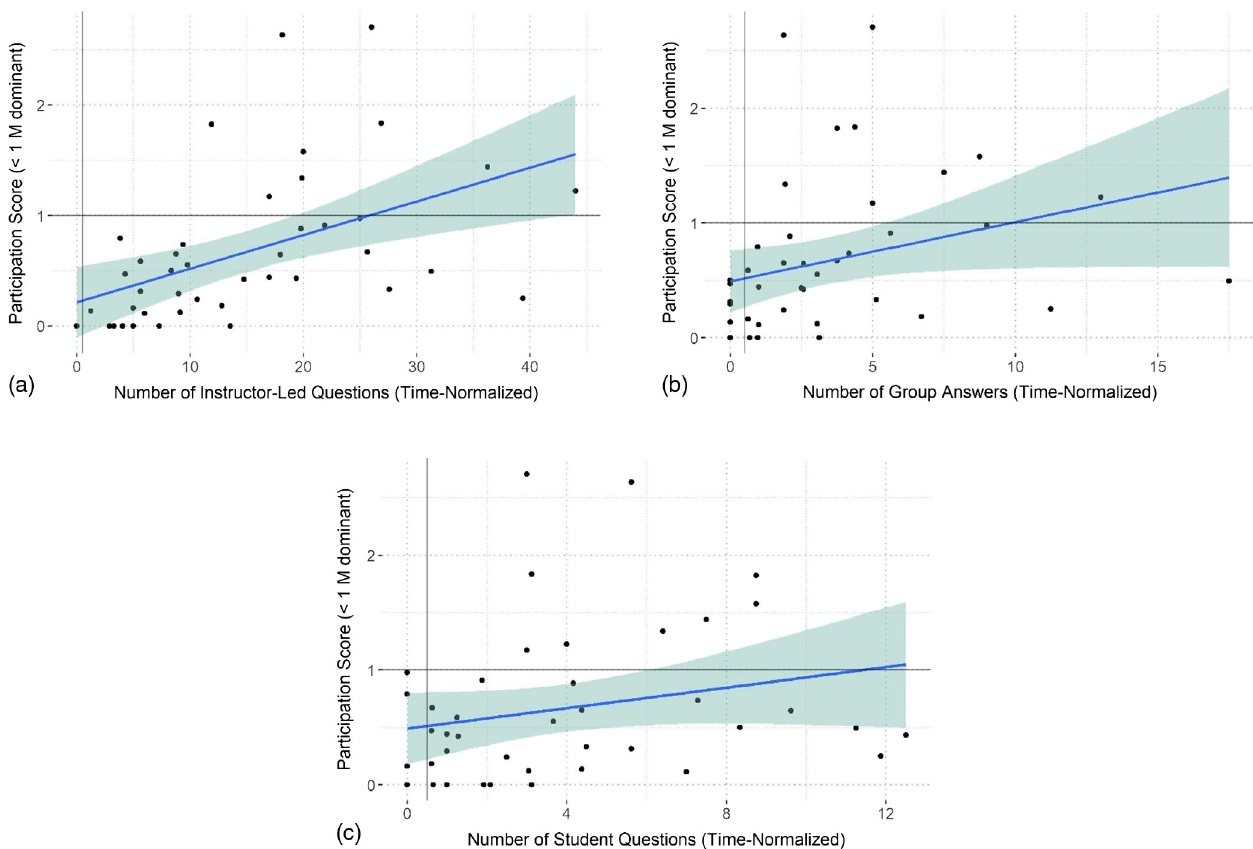
FIG. 5. An increase in the number of (a) instructor-prompted questions, (b) group responses, and (c) student questions appears to be strongly correlated with a higher participation score (regardless of category). Scatterplots of physics observations by the (time- normalized) number of instructor questions ( x axis) and participation score ( y axis). Simple regression lines illustrate the linear relationship between instructor-led questions and participation scores (shaded area represents the 95% confidence